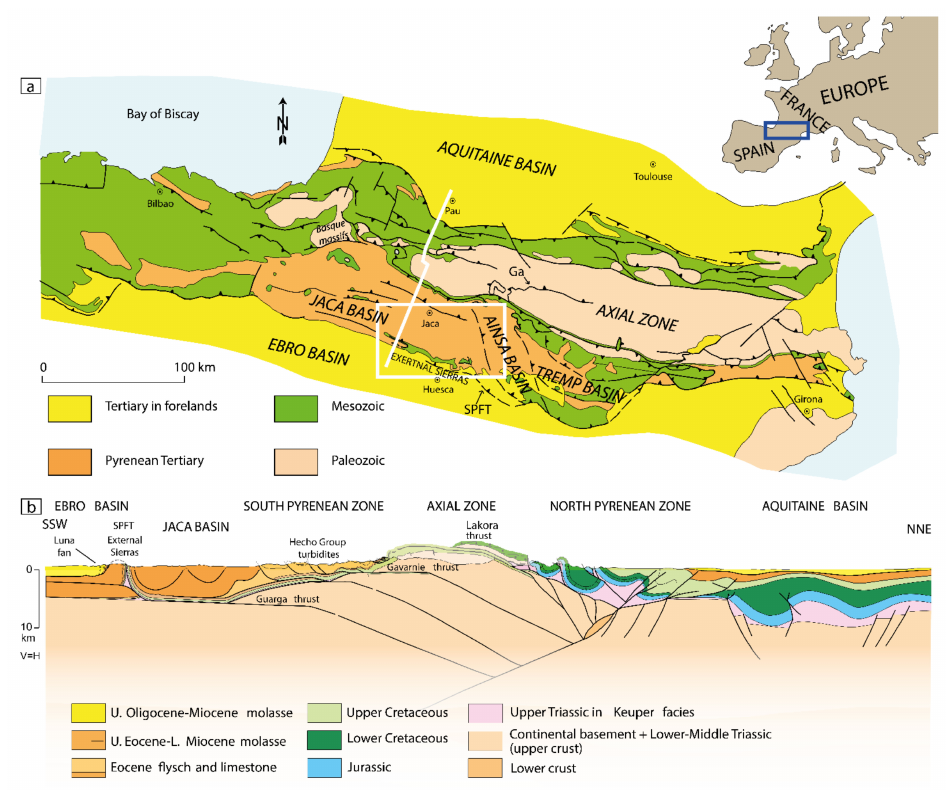
Figure 1. ( a ) Simplified geological map of the Pyrenees (redrawn from Teixell et al. [35]), showing the location of the study area (white frame). White line indicates cross-section in Figure 1b. White box corresponds to study area. Ga: Gavarnie thrust, SPTF: South Pyrenean Frontal Thrust. ( b ) Crustal cross-section of the west-central Pyrenees (simplified from Teixell et al. [36]), showing both the South Pyrenean Zone and the North Pyrenean